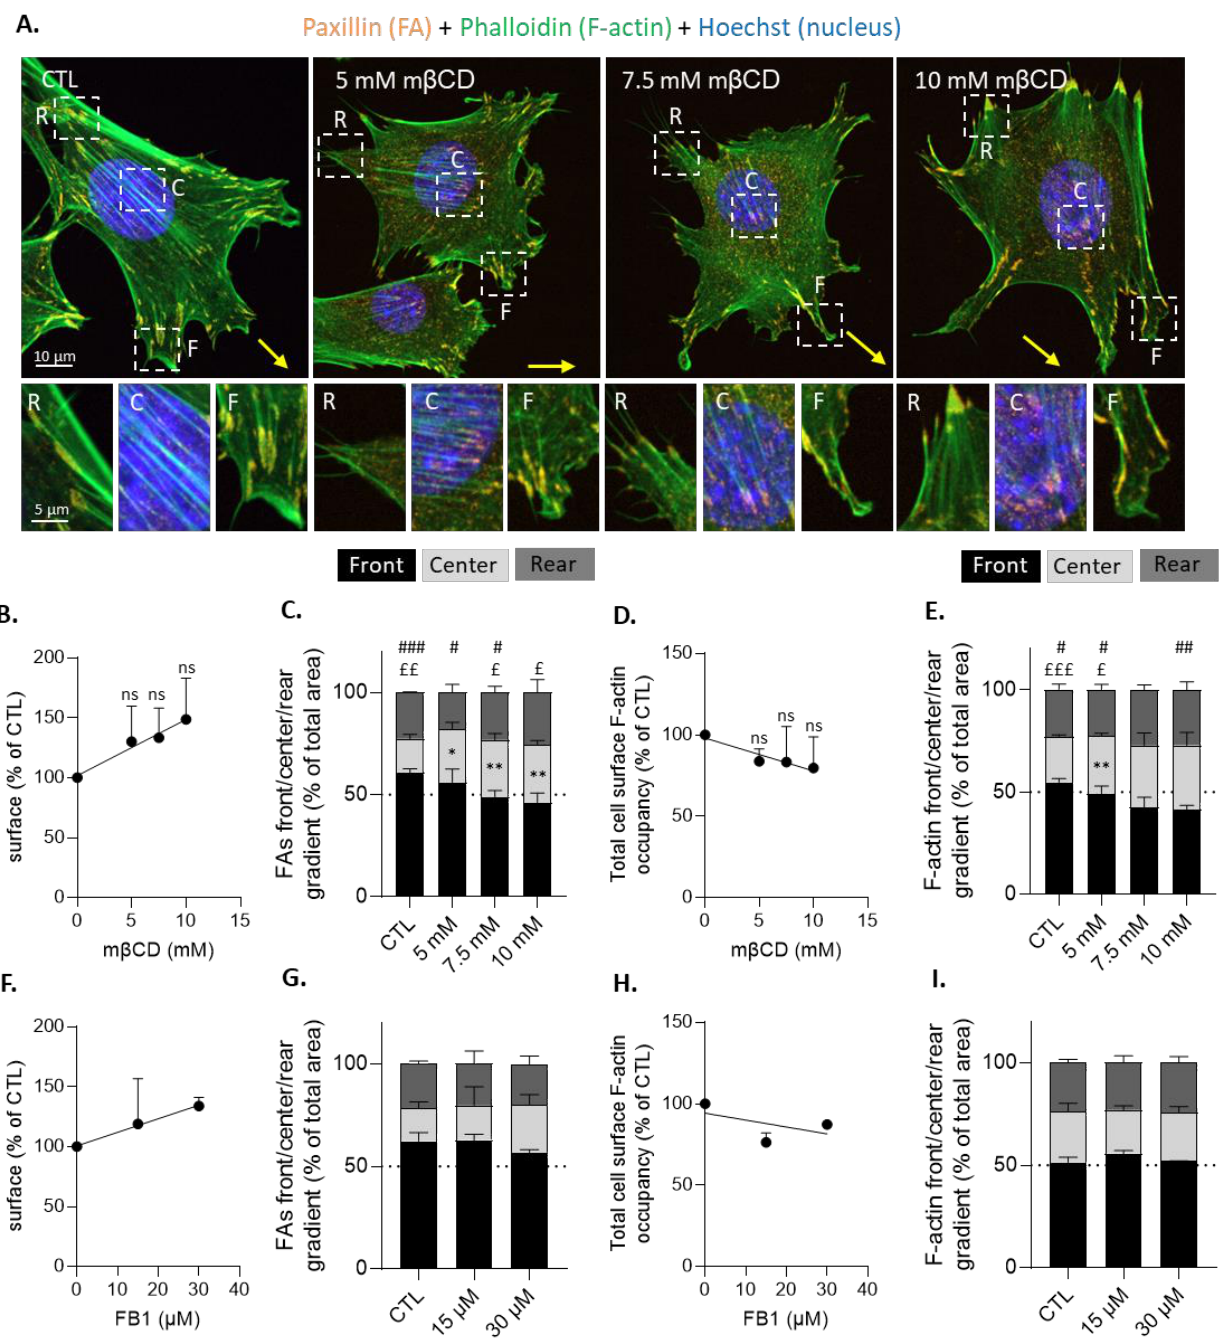
Figure 9. In contrast to sphingolipid synthesis inhibition, cholesterol depletion impairs polarization of focal adhesions and to a lower extent of F-actin upon myoblast migration. Cells were pretreated with the indicated concentrations of mβCD ( A – E ) or FB1 ( F – I ), migrated for 5 h in Ibidi chambers, and then immunolabeled for F-actin (green), paxillin (orange), and nuclei (blue). ( A ) Representative images. R, rear; C, center; F, front. Arrows indicate the direction of migration. ( B – I ) The quantification of FA total number relative to cell surface ( B , F ), FA polarization ( C , G ), F-actin total cell surface occupancy ( D , H ), and F-actin polarization ( E , I ). The polarization data are expressed as % of FAs or F-actin total area (means ± SD, n = 3 independent experiments in ( A – E ) and 2 independent experiments in ( F – I ). Two-way ANOVA followed by Tukey’s multiple comparisons test. #, comparison between F and R in a condition; £, comparison between F and C in a condition; and *, comparison of C in a treated condition with the C of control condition.